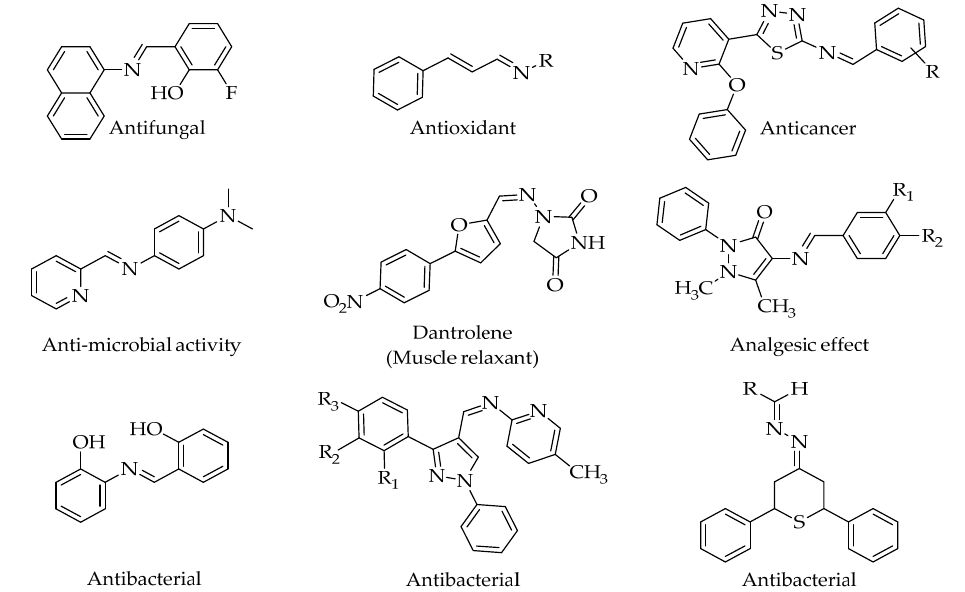
Figure 1. Chemical structures of some pharmacologically active Schiff bases.